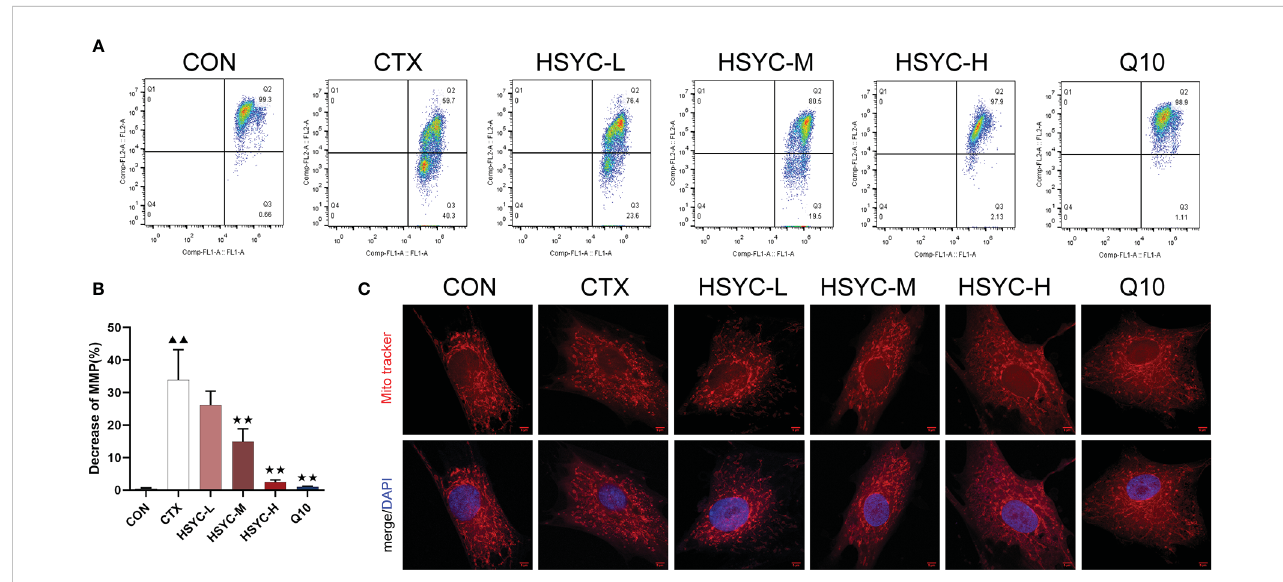
FIGURE 4 HSYC improved mitochondrial dysfunction in ovarian granulosa cells of POI af fl icted mice. (A) Flow cytometric analysis of mitochondrial membrane potentials degradation, Q2 represents granulosa cells with normal mitochondrial membrane potentials and Q3 represents granulosa cells with decreased mitochondrial membrane potentials. (B) The histogram plots means with SD of fl ow cytometric analysis of mitochondrial membrane potentials degradation. Histogram elements represent the mean ± SD (n=3). ▲▲ presents P < 0.01 compared to the CON group; ★★ presents P < 0.01 compared to the CTX group. (C) . Observation of mitochondria morphology by MitoTracker Red staining. Red color represents the mitochondria and blue represents nucleus of granulosa cells. Scale Bar: 5µm.